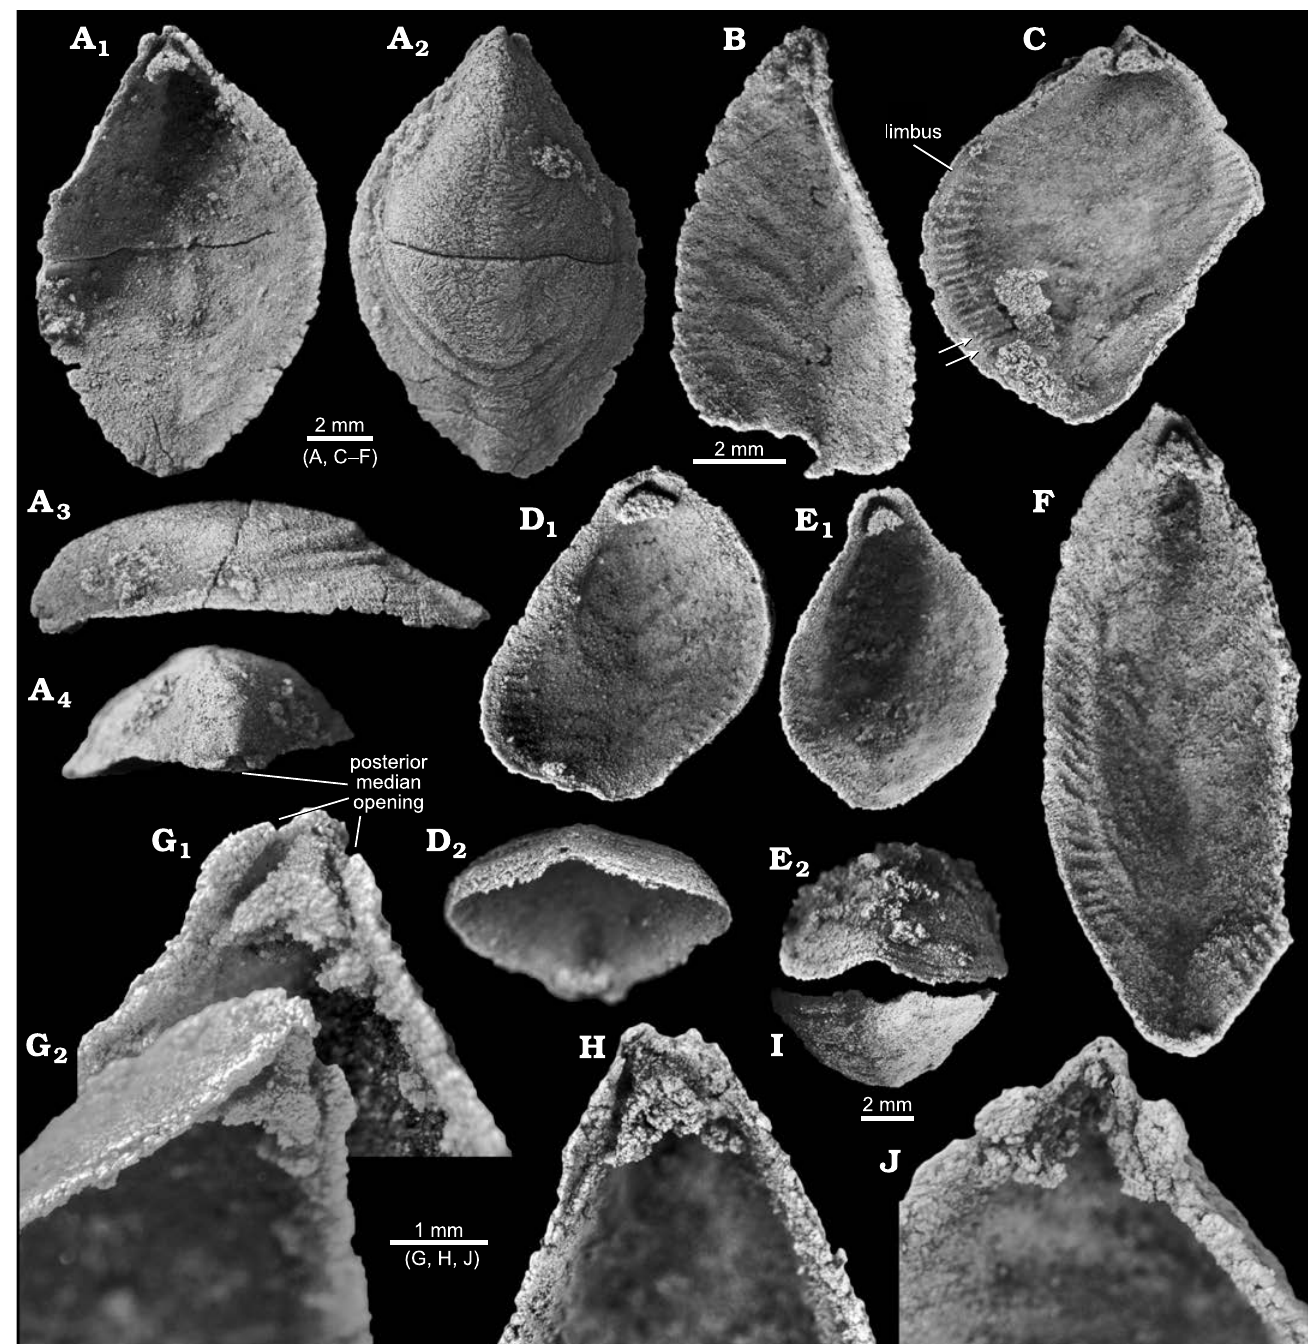
Fig. 5. Stenothecoid pan-brachiopod Stenothecoides rasettii sp. nov., middle Cambrian, Burgess Shale Formation, Yoho National Park, Canada, Locality 2 (A, G) and Locality 1 (B–F, H–J). A . TMP 2002.083.0178, dorsal valve in interior (A 1 ), exterior (A 2 ), right lateral (A 3 ), and posterior (A 4 ) views. B . TMP 2008.024.1138, ventral valve in interior view. C . TMP 2008.024.1133, dorsal valve in interior view, arrows show possible bifurcated peripheral ridges. D . TMP 2008.024.1143, dorsal valve in interior (D 1 ) and anterior oblique (D 2 ) views. E . TMP 2008.024.1144, dorsal valve in interior (E 1 ) and anterior (E 2 ) views. F . TMP 2008.024.1134 , ventral valve, interior view. G . TMP 2002.083.0177 (same specimen as Fig. 4B), ventral valve in interior (G 1 , magnified) and oblique (G 2 ) views. H . TMP 2008.024.1135, dorsal valve in interior view. I . TMP 2008.024.1121, ventral valve, anterior view. J . TMP 2008.024.1136, ventral valve in interior view, showing detached apical boss and remnant apical stem and cardinal